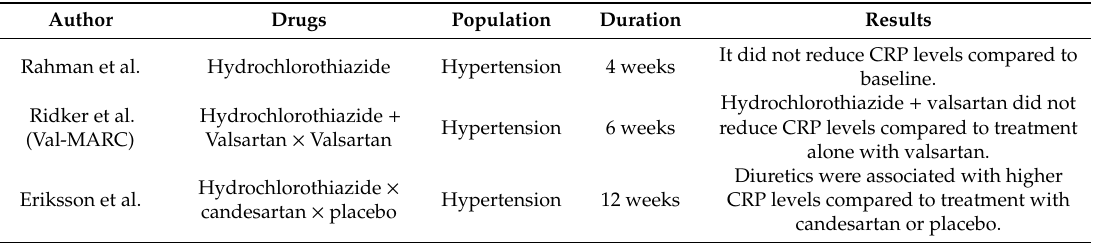
Table 4. Randomized clinical trials showing the e ff ect of treatment with diuretics on serum levels of C-reactive protein.